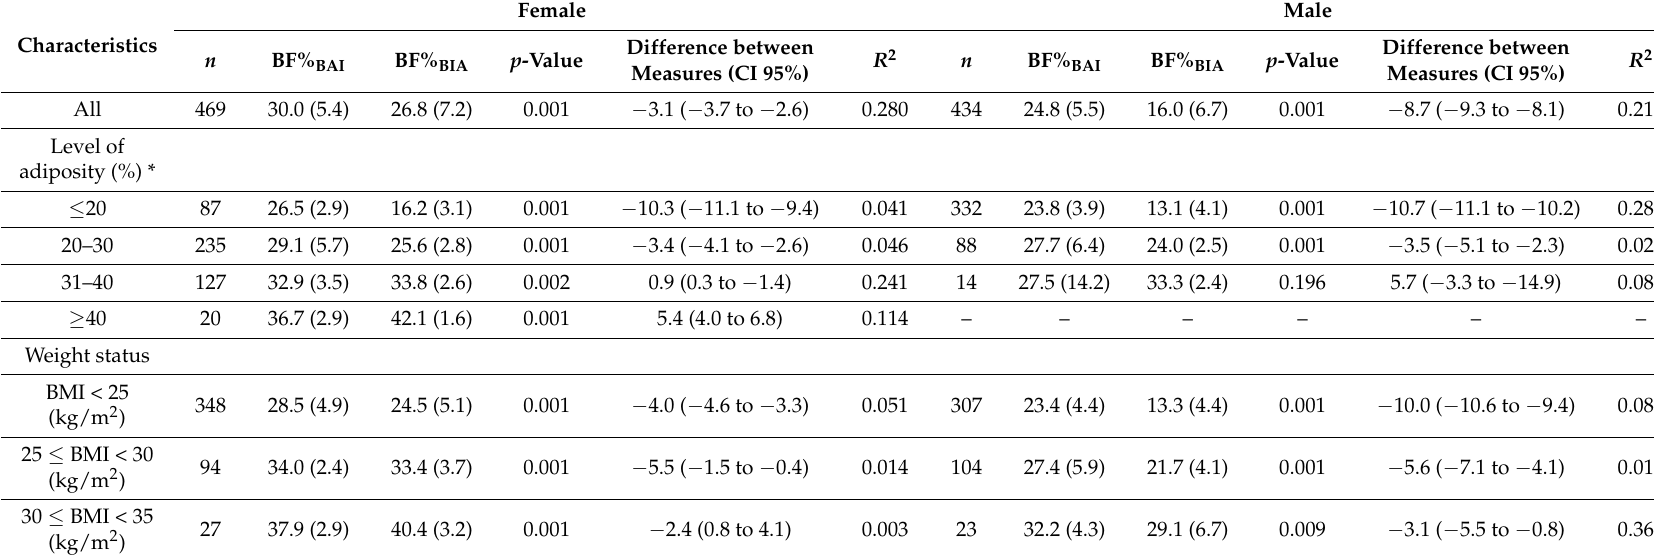
Table 2. Body fat percentage by BAI and BIA according to different levels of adiposity and weight status by gender.